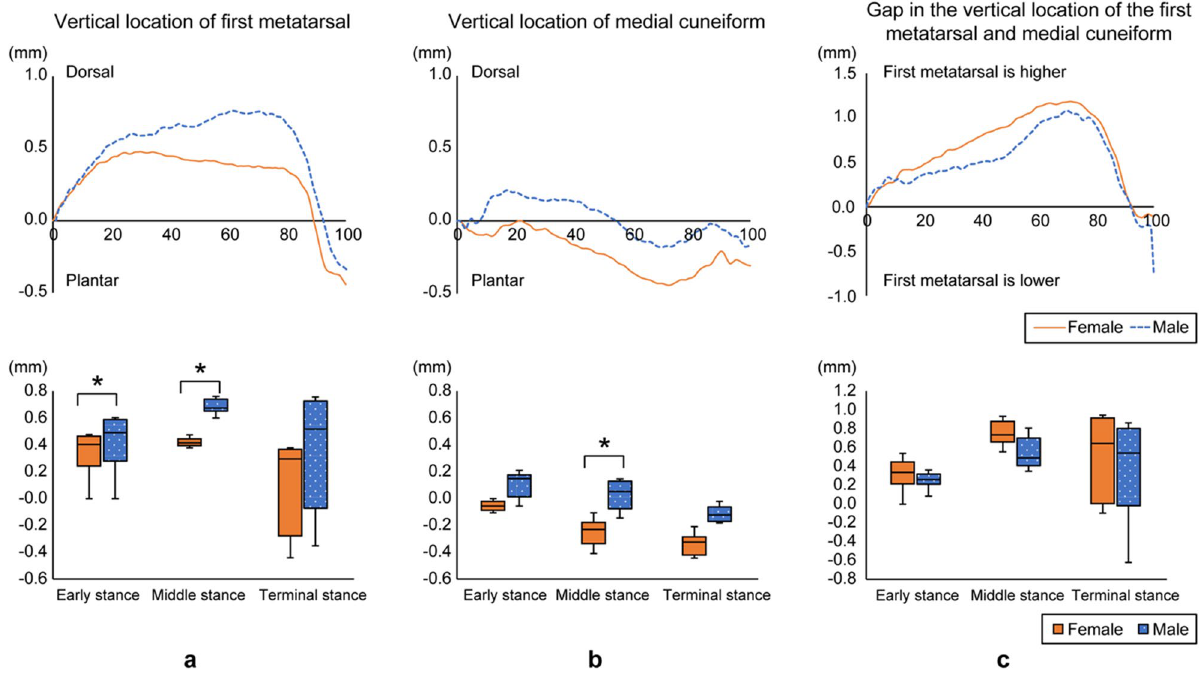
Figure 3. Gender differences in first tarsometatarsal joint movement during one stance phase of gait. Temporal changes in the vertical location of the first metatarsal ( a ), medial cuneiform ( b ), and displacement of the two ( c ) are shown for males and females. Box plots comparing the vertical locations during the early, middle, and terminal stance phases are shown. *p < 0.01. Significant plantar displacement was observed in the vertical location of the first metatarsal in early and middle stance and in the vertical location of the medial cuneiform in middle stance in female compared to male.